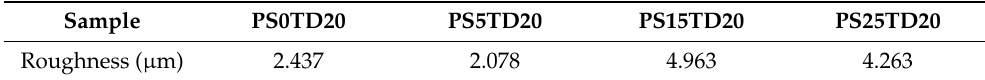
Figure 3. Roughness of the coating: ( A ) PS0TD20, ( B ) PS5TD20, ( C ) PS15TD20, and ( D ) PS25TD20. Table 6. The roughness of the coating.